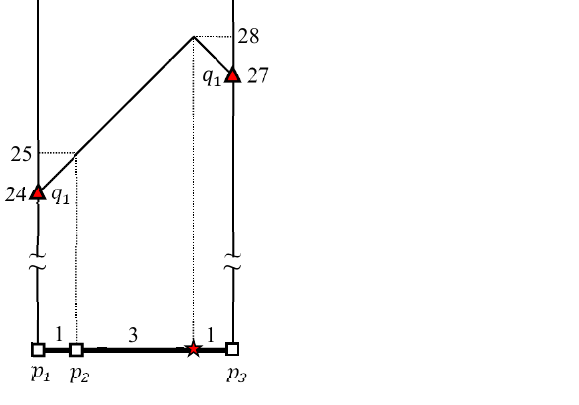
Figure 5. maxdist ( q 1 , { p 1 p 2 p 3 } ) = 28 and mindist ( q 1 , { p 1 p 2 p 3 } ) =